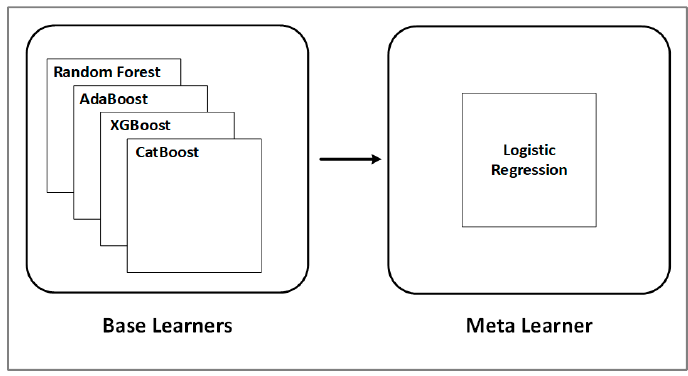
Figure 2. Structure for the stacking-based model.